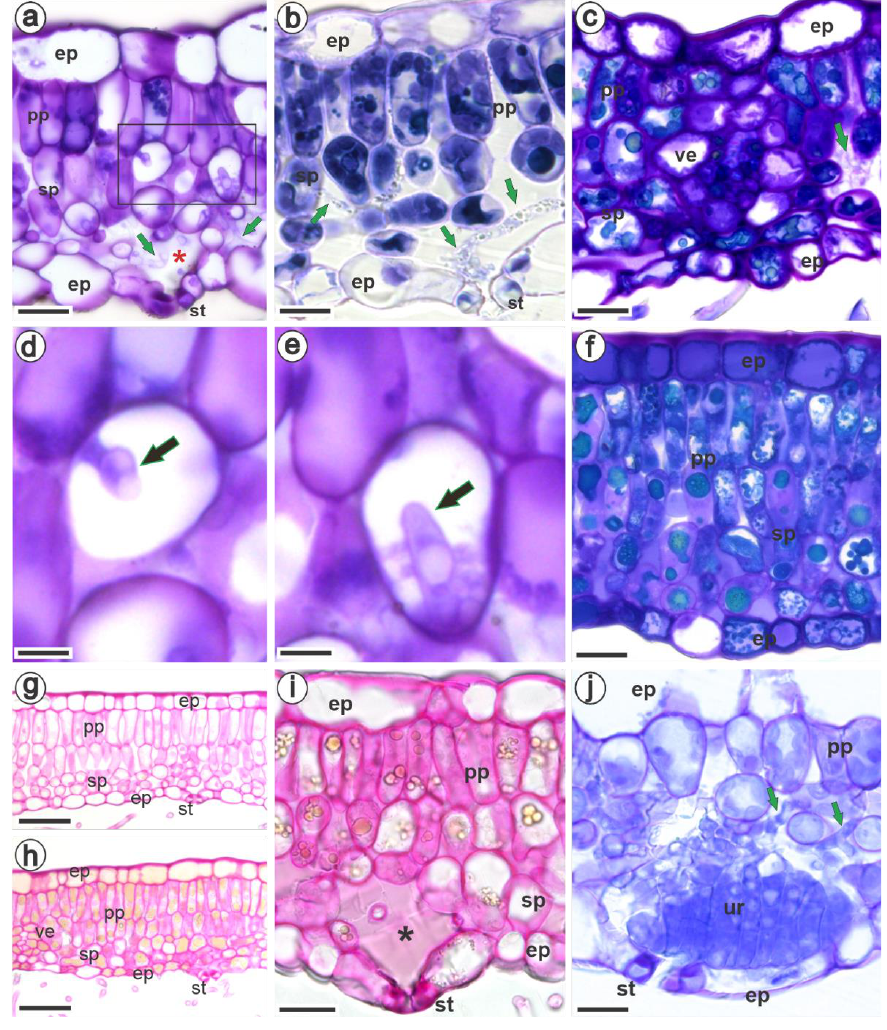
Figure 3. Cross-sections of Rubus idaeus cv. Autumn Bliss ( a , d , e , j ), R. occidentalis ( b , i ), and R. niveus ( c , f , g , h ) leaves 14 days after inoculation with Aculeastrum americanum , stained with toluidine blue ( a – f , j ) or with ruthenium red ( g – i ). ( a – c ) Hyphae in the intercellular space of the spongy parenchyma (arrows), especially in the substomatal chamber. ( d , e ) Detail of the black frame in ‘a’ showing the haustorium (black arrow) inside the spongy parenchyma cell. The mesophyll cells accumulated more phenols in infected areas ( f , h , i ) than in uninfected areas of the same leaf lamina ( g ); black raspberries also exhibited intercellular spaces filled with pectic substances ( f , i ). ( j ) Initial stages of uredinium formation in the substomatal chamber. Phenols are shown as intense blue ( a , b ) or greenish-blue ( c , f ) dots stained with toluidine blue, and yellow dots stained by ruthenium red ( h , i ). Pectic substances were stained purple by toluidine blue ( f ) and pink by ruthenium red ( h , i ). ep, epidermis; pp, palisade parenchyma; sp, spongy parenchyma; ve, vein; st, stoma; ur, uredinia; *, substomatal chamber. Bars: ( a , i ): 20 µ m, ( b ): 12 µ m, ( c , f , j ): 15 µ m, ( d – e ): 5 µ m, ( g , h ): 40 µ